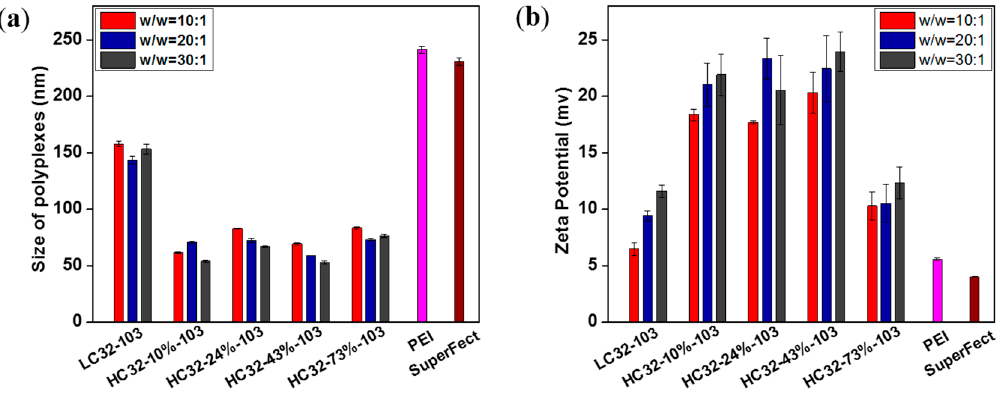
Figure 1. Size and potential of polyplexes formulated with different w / w ratios measured by Dynamic Light Scattering (DLS): ( a ) Size of polymer/DNA polyplexes; ( b ) Zeta potential of